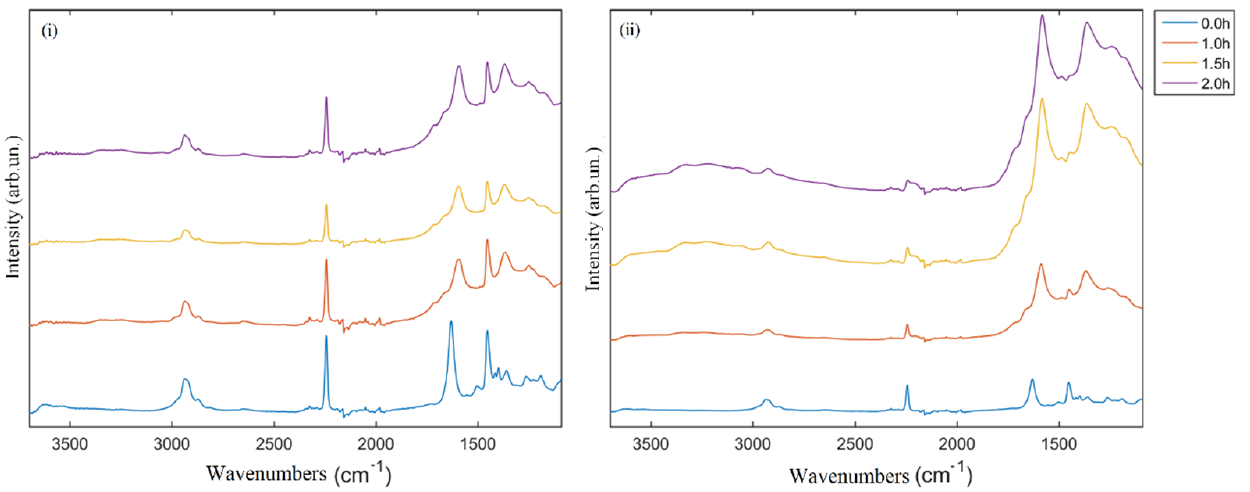
Figure 4. FT-IR (ATR mode) of electrospun CNFs precursor (0.0 h) then stabilized in air at ( i ) 230 and ( ii ) 260 °C for times ranging from 1 up to 2 h.